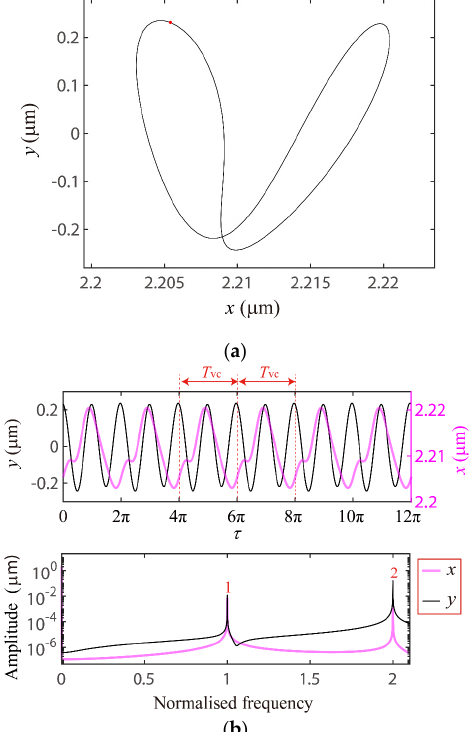
Figure 11. For δ 0 = − 1.5 µ m, response characteristics of the VC superharmonic motion when Ω = 131.6 rad / s, ( a ) orbit (black line) and its Poincare mapping (red dots), ( b ) time series and their frequency